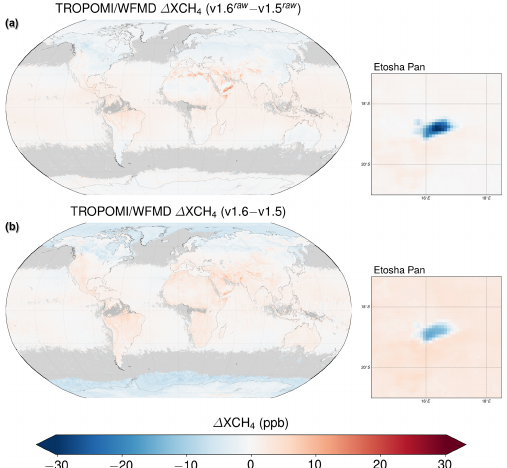
Figure 2. Global differences in XCH 4 (2018–2020) when changing the polynomial degree from 2 to 3 (a) before and (b) after appli- cation of the machine learning calibration. The largest differences are observed over the Etosha Pan. The differences in northern Africa and on the Arabian peninsula are largely resolved via the calibration when using a quadratic polynomial as these features are mitigated in the lower